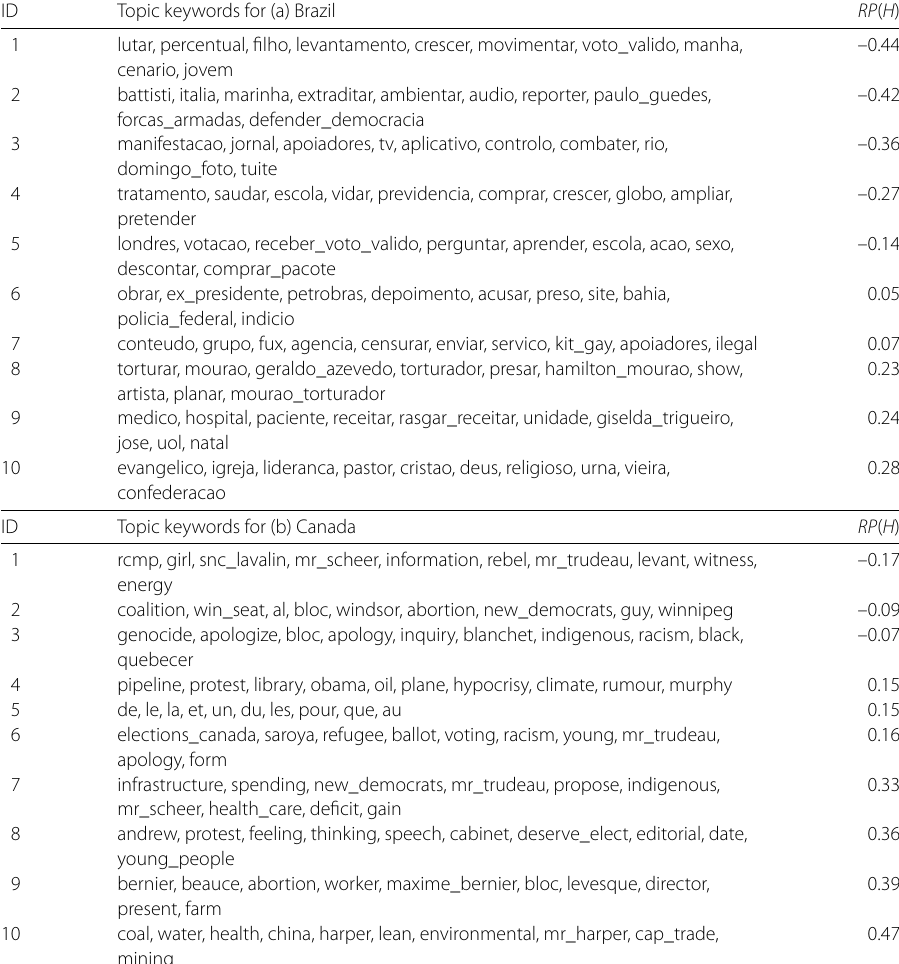
Table 5 Heatmap data references for Fig. 11